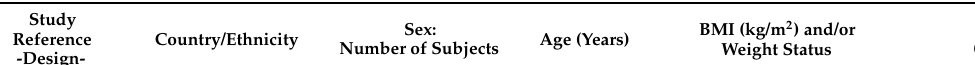
Ideal vs. current figure Larger: